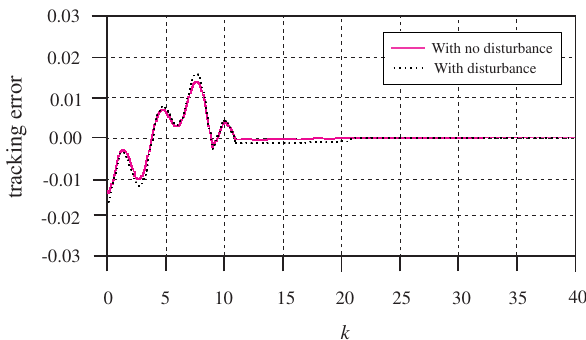
Figure 6. The tracking errors with exogenous disturbance in the case of M r = 7, M d = 6.